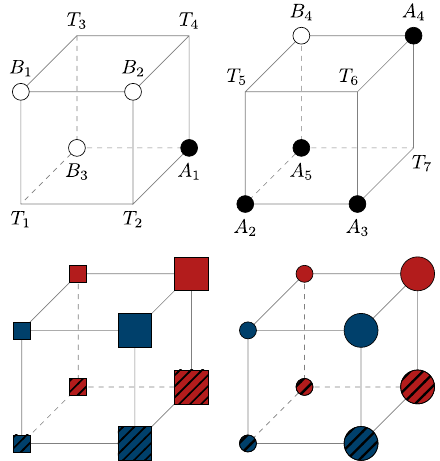
Figure 1. Categories and stimulus items of the categorization task. At the top, the 5–4 category set of Medin and Schaffer 50 , represented here in a Hasse Diagram forming a hypercube. Members of category A are represented by black dots, members of category B are represented by white dots, and transfer items are represented by empty vertices. At the bottom, illustration of the stimulus items that varied along four Boolean dimensions (Color, Shape, Size and Filling